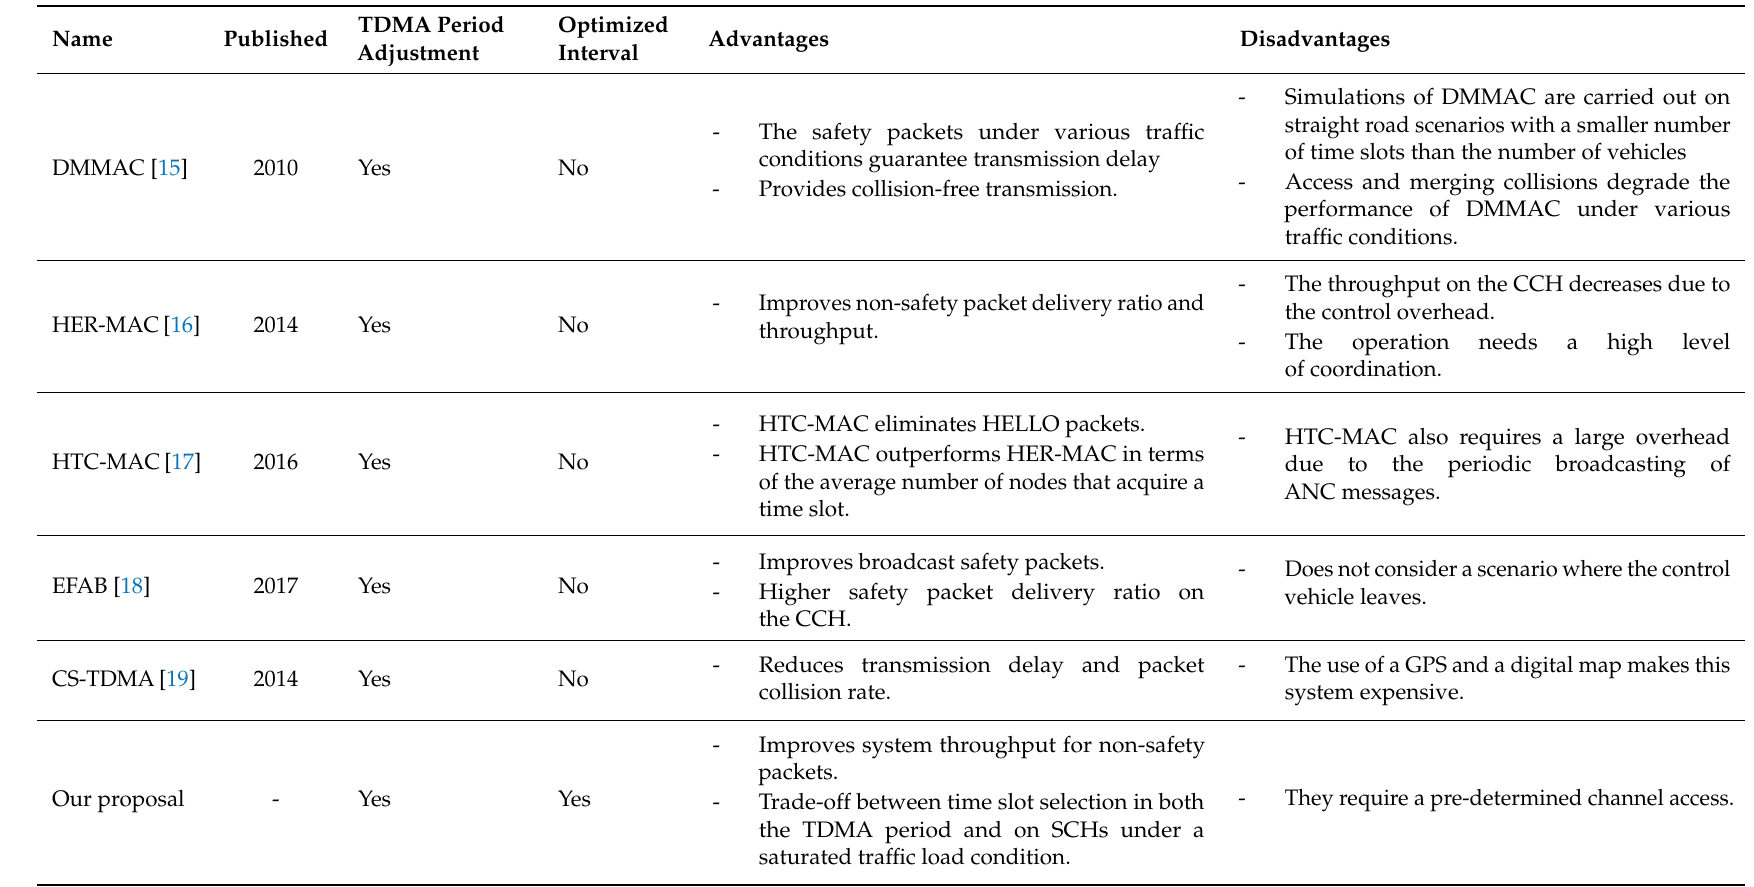
Table 2. Comparison of hybrid MAC protocols in